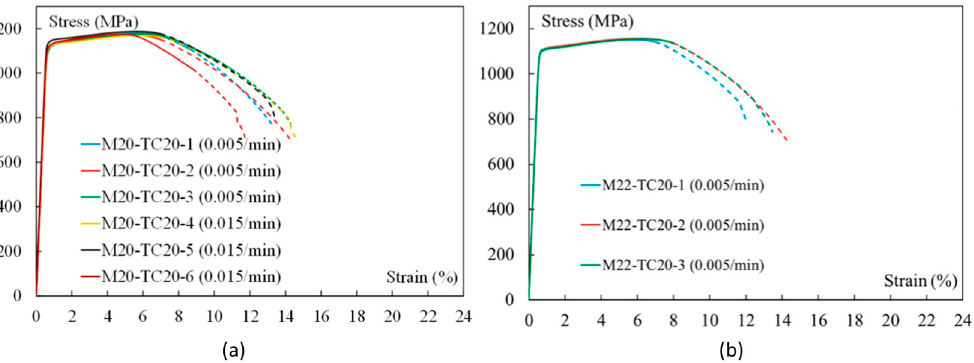
Figure 9. Stress–strain response of ( a ) M20 and ( b ) M22 grade 10.9 HP bolts, at a temperature of 20 °C [90].